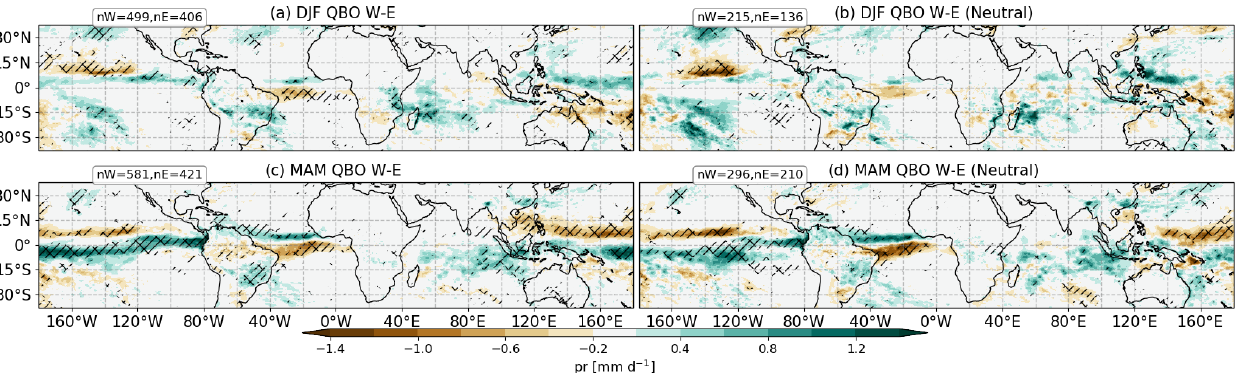
Figure 4. Composite QBO W–E differences of total precipitation in GC3 N216-pi in (a, b) DJF and (c, d) MAM for (a, c) all the events and (b, d) ENSO-neutral conditions only. The sample size of each composite is noted in the top left corner of each panel. Statistically significant differences to the 95% confidence level are shown through the